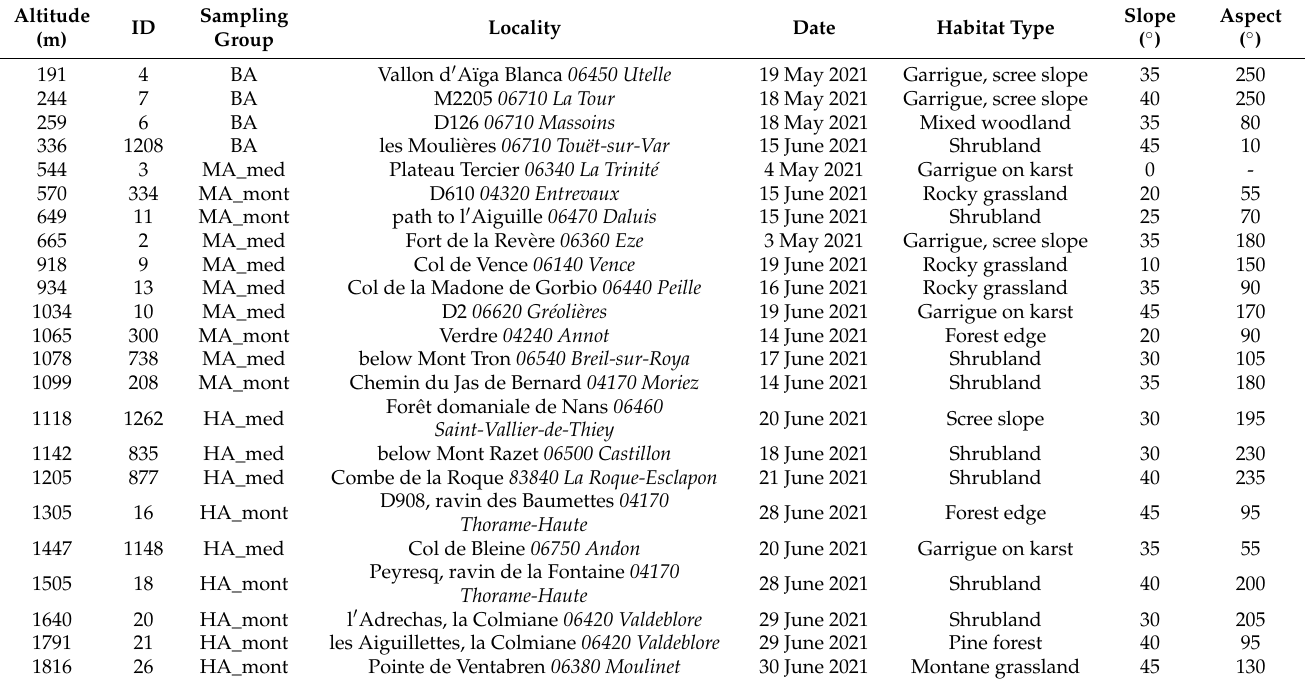
Table 2. Location and characteristics of the sampled sites along the altitudinal gradient. Group codes are: BA: low altitude (<350 m), MA: mid-altitude (350–1100 m), HA: high altitude (>1100 m), med: Mediterranean, mont: